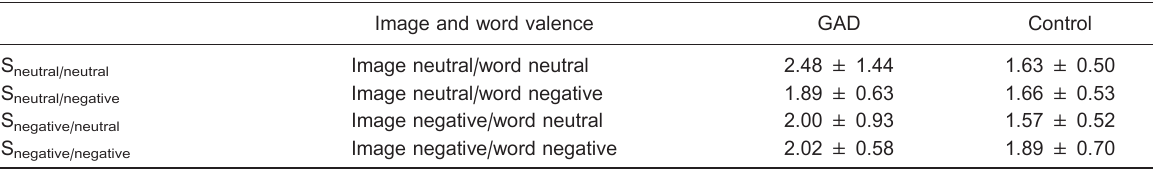
Table 1. Reaction times under each condition